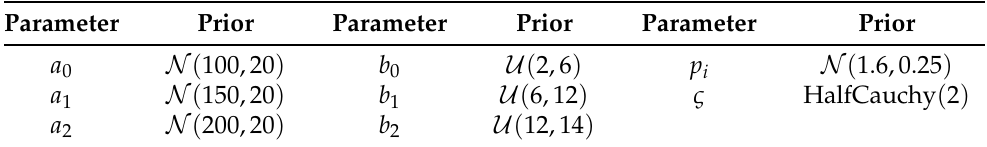
Table 1. Prior distributions. The notation N ( µ , σ ) stands for the normal distribution with mean µ and standard deviation σ . U ( x l , x u ) stands for the uniform distribution with lower bound x l and upper bound x u , and the HalfCauchy ( γ ) is the truncated Cauchy distribution with scale parameter γ .